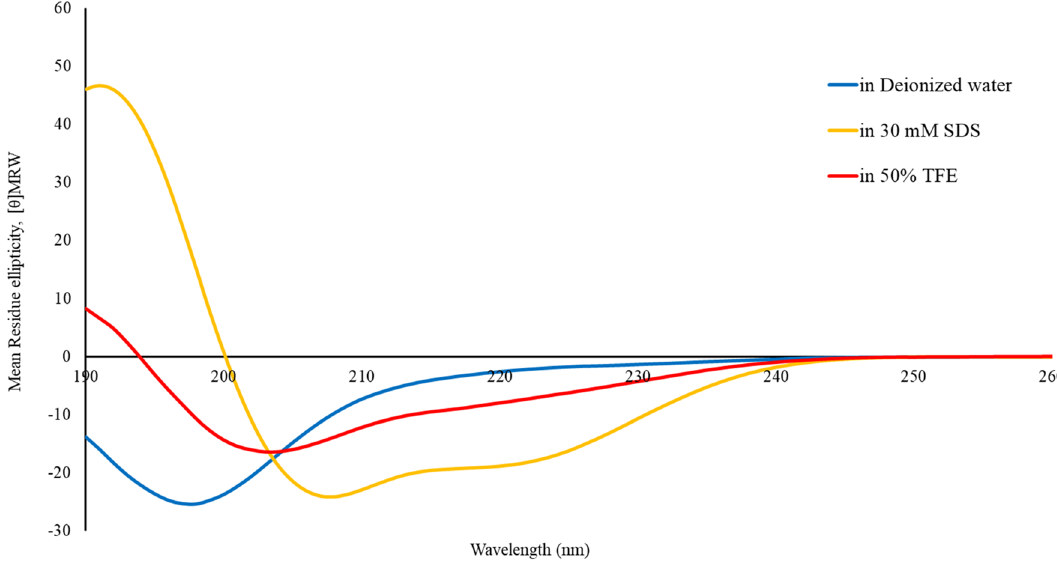
Figure 5. Conformational changes of A11 peptide, evaluated by CD spectroscopy. CD spectra of A11 in aqueous solution (deionized water), 30 mM SDS micelles, and 50% TFE are displayed in blue, yellow, and red,